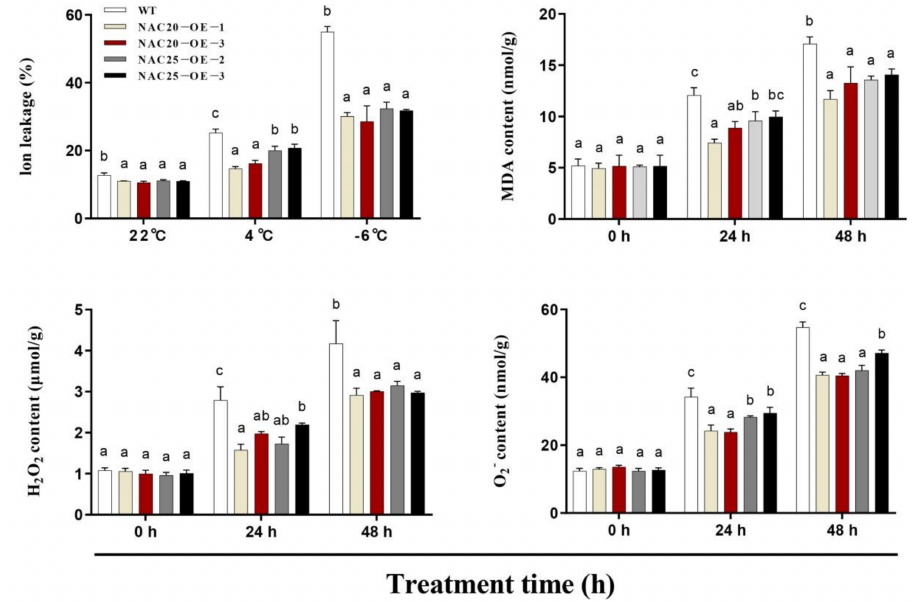
Figure 10. Changes of ion leakage, MDA content, H 2 O 2 , and O 2 − of WT and transgenic lines under cold stress. Ion leakage were determined in WT and transgenic lines under cold stress (4 ◦ C for 48 h) and freezing ( − 6 ◦ C for 6 h) treatments. MDA, H 2 O 2 , and O 2 − accumulation were determined in WT and transgenic lines under cold stress (4 ◦ C for 48 h) . Data represent average values from three biological replicates ( ± S.D.). The different letters above bars indicate significant differences at the p < 0.05 level according to Duncan’s multiple comparison